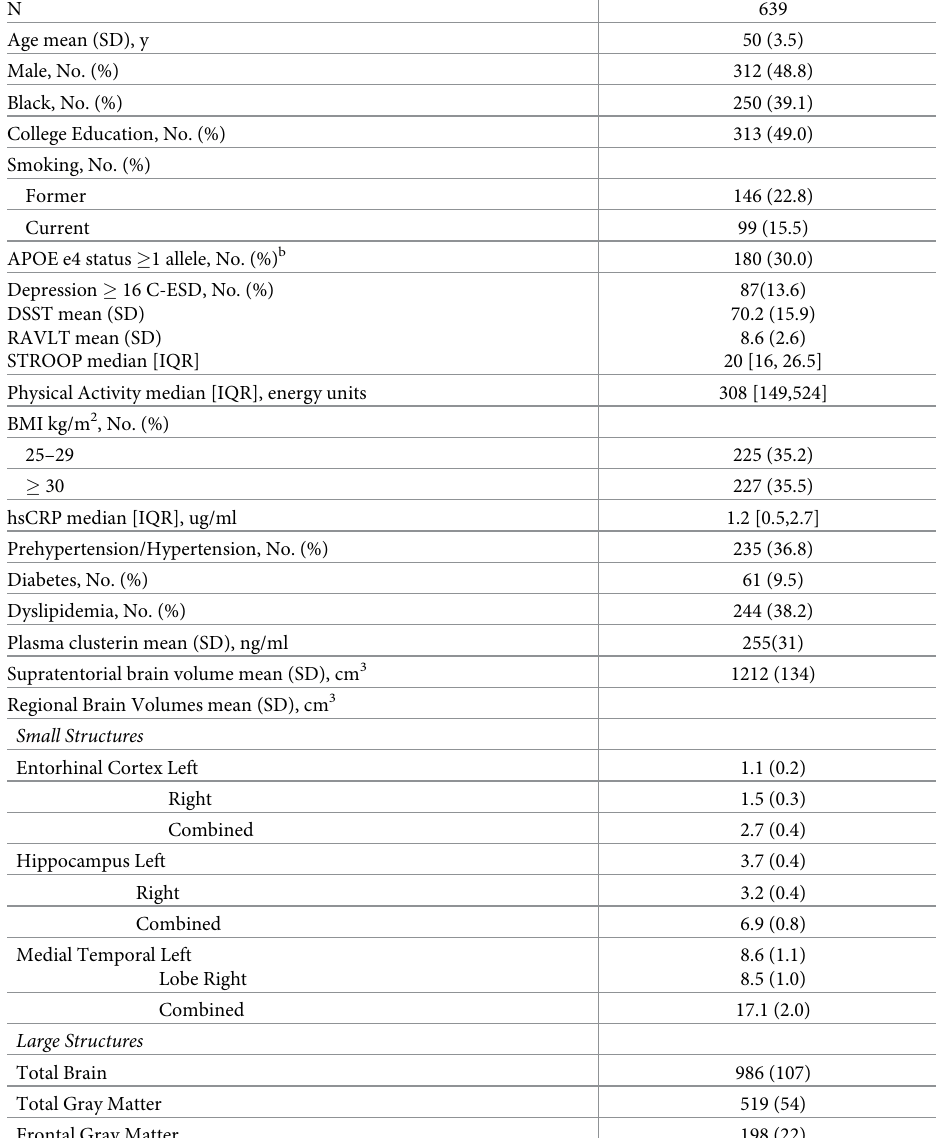
Table 1. Characteristics of CARDIA Brain MRI sub-study participants a